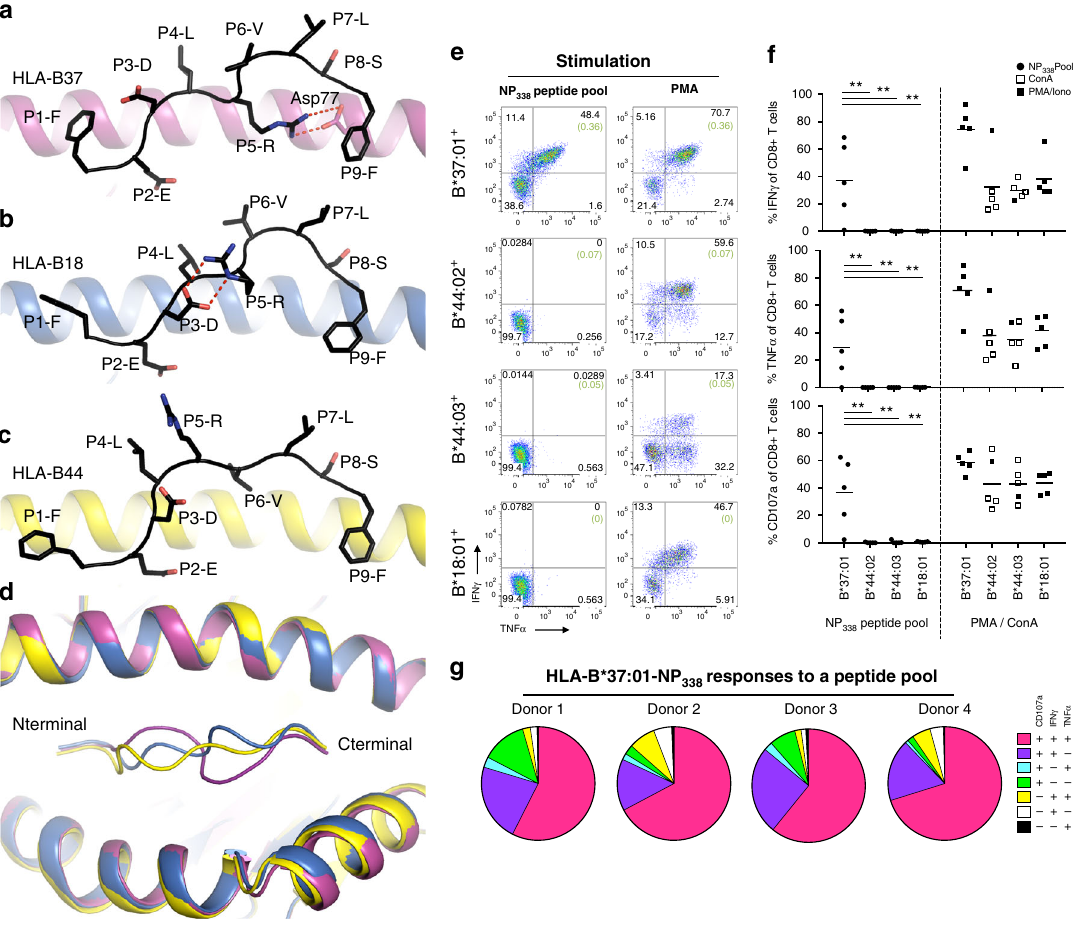
Fig. 1 NP 338 elicits robust CD8 + T cell responses only in the context of HLA-B*37:01. a – d Crystal structures of a HLA-B*37:01 (purple), b HLA-B*18:01 (blue), and c HLA-B*44:05 (yellow) in complex with NP 338 WT (represented in black stick). d is showing an overlay of the three peptide – HLA complexes in cartoon representation, with NP 338 colored accordingly to the bound HLA, namely, purple (HLA-B*37:01), blue (HLA-B*18:01), and yellow (HLA-B*44:05). e – g PBMCs from HLA-B*37:01 + donors ( n = 5), HLA-B*44:02 + donors ( n = 5), HLA-B*44:03 + donors ( n = 5), or HLA-B*18:01 + donors ( n = 5) were stimulated with a pool of NP 338 peptides (10 μ M each peptide, 30 μ M total), and speci fi city was assessed in an ICS assay against 3 μ M NP 338 pool (1 μ M each peptide, HLA-B*44:02 + donors) directly into the well or 30 μ M (10 μ M each peptide, all other donors) NP 338 -pooled pulsed APC lines (HLA-B*37:01, HLA-B*44:03, and HLA-B*18:01). CD8 + T cells are gated on lymphocytes, singlets, live + (when stained with the second antibody cocktail only) CD3 mid-high , CD8 + T cells; as per Supplementary Fig. 2a. e Representative dot plots of IFN γ + TNF α + production by pooled CD8 + T cell lines derived from HLA-B*37:01 + , HLA-B*44:02 + , HLA-B*44:03 + , or HLA-B*18:01 + donors, towards a pool of NP 338 peptides. No peptide control represented in brackets. f Summary of IFN γ , TNF α , and CD107a production, minus no peptide controls, against the pool of NP 338 peptides (closed circle) or a positive control (ConA open square or PMA closed square) across multiple donors. Statistical analysis using a Dunnett's two-way ANOVA in which * p ≤ 0.05, ** p ≤ 0.01, and *** p ≤ 0.001. g Summary of the polyfunctional pro fi les, minus background, from the four HLA-B*37:01 + donors who responded towards the pool of NP 338